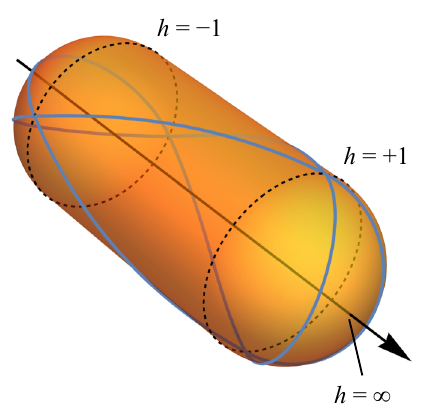
Figure 3: Isometric embedding of the h φ -ground-state manifold with a geodesic